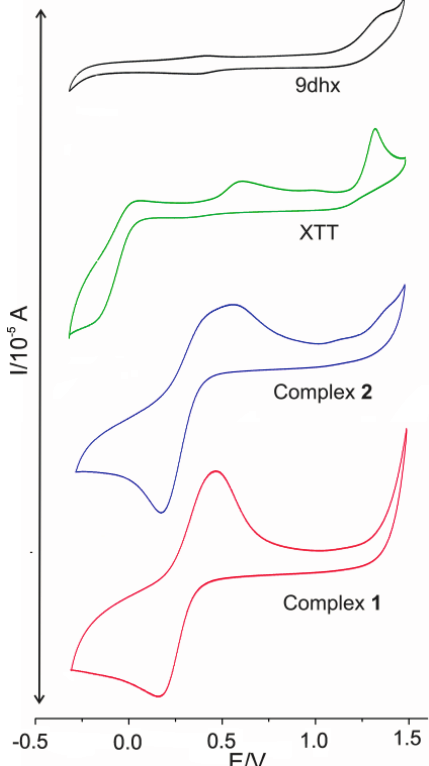
Figure 7. Cyclic voltammograms of 5 mM solutions of complexes 1 (red), 2 (blue), XTT (green) and 9dhx (black) in 0.1 M tetrabutylammonium perchlorate (TBAP) in DMSO (glassy carbon working electrode, potential referred to standard hydrogen electrode